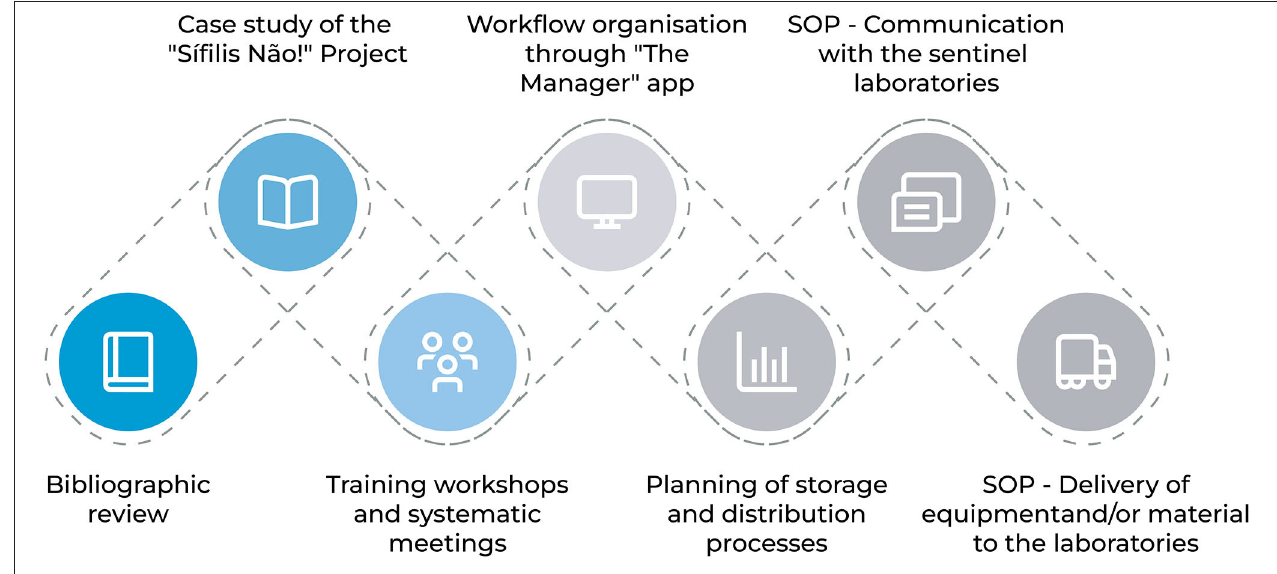
FIGURE 1 | Steps for the methodological